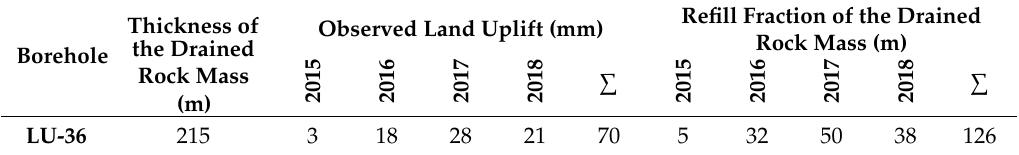
Table 3. Determination of the change in the groundwater head in the Zechstein aquifer for the Lubich ó w mine area. The thickness of the drained rock mass in the analyzed borehole was obtained from